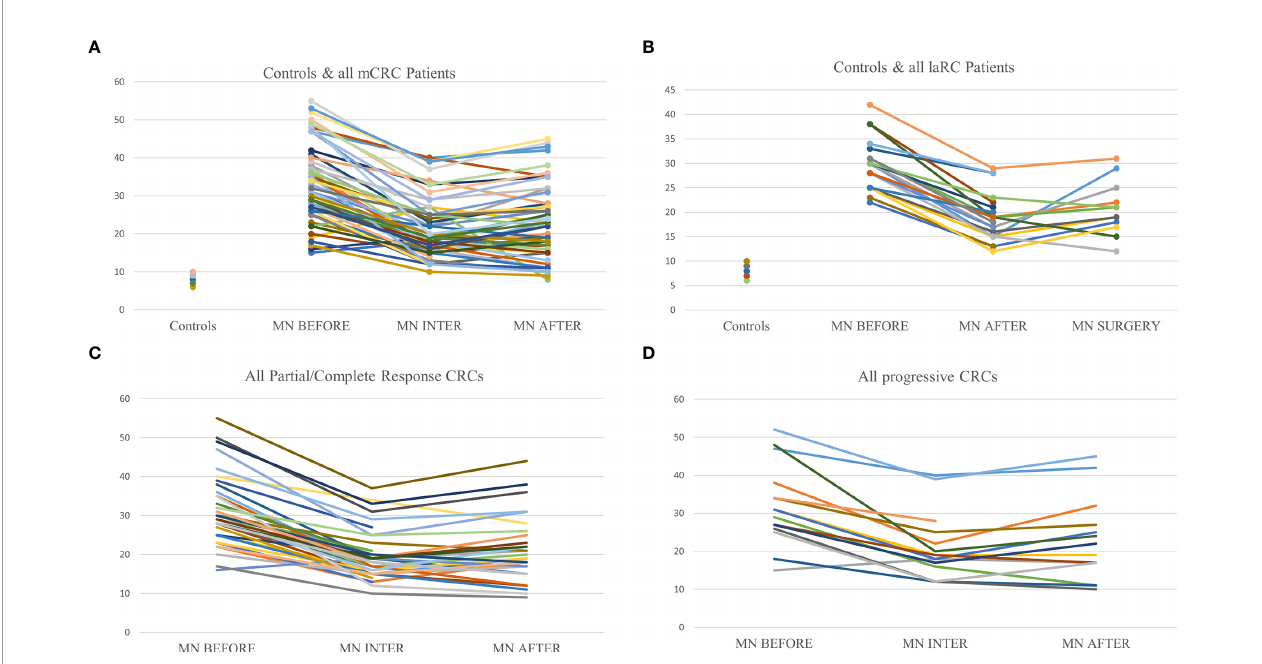
FIGURE 3 | Graphic representation of MNf in controls and the trends between sampling points for every patient. (A) Presentation of MNf trend for controls and all mCRC patients; (B) presentation of MNf trend for controls and laRC patients; (C) presentation of MNf trend for all patients (mCRC and laRC) with partial or complete response; (D) presentation of MNf trend for all patients (mCRC and laRC) with progressive